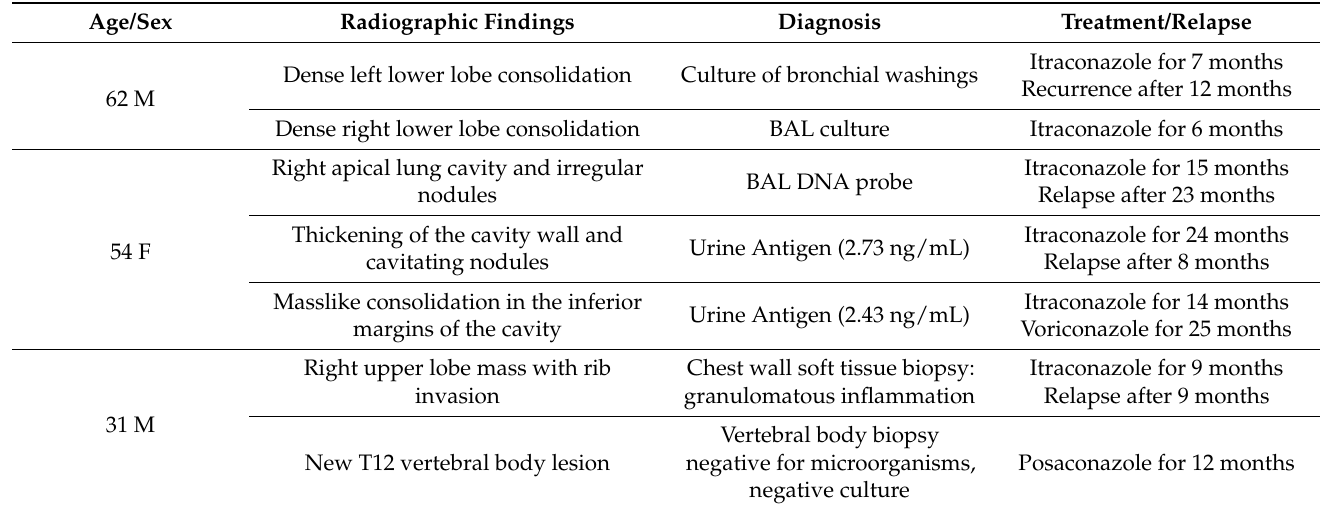
Table 6. Clinical characteristics of patients with recurrent/relapsed